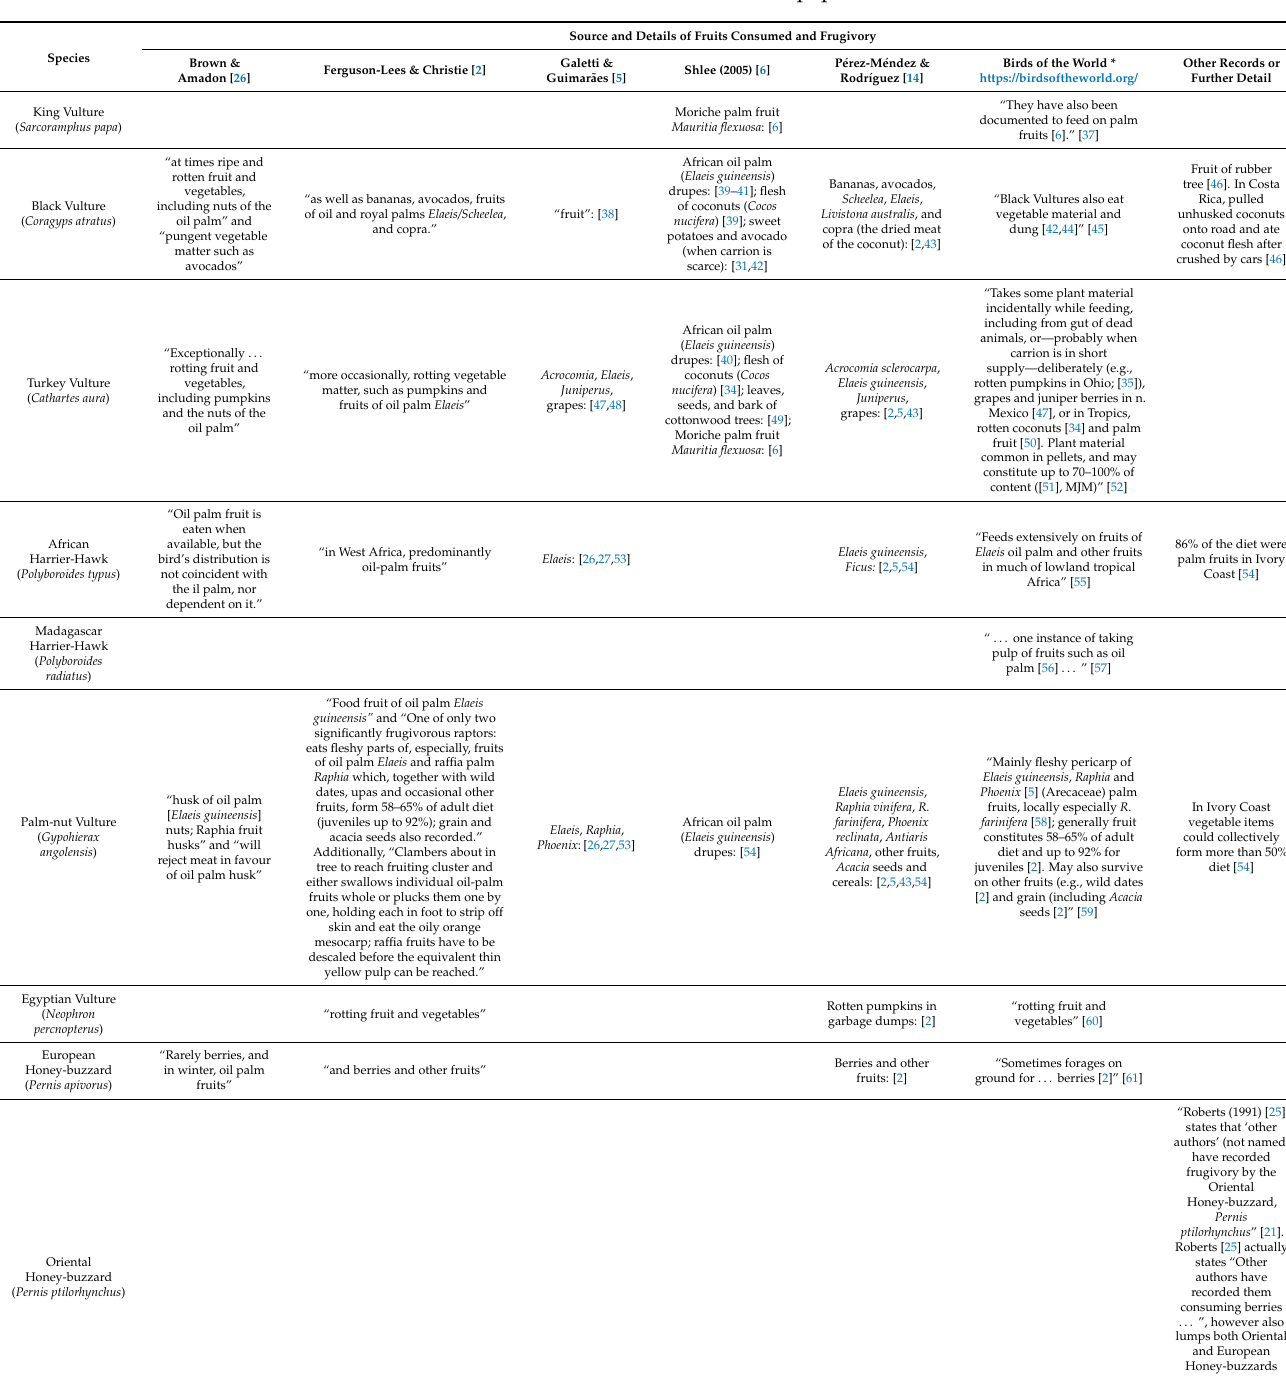
Table 1. Comparisons of lists of raptors consuming fruits or other vegetable matter from major handbooks or reviews, as well as other records not listed in those sources, and observations from this